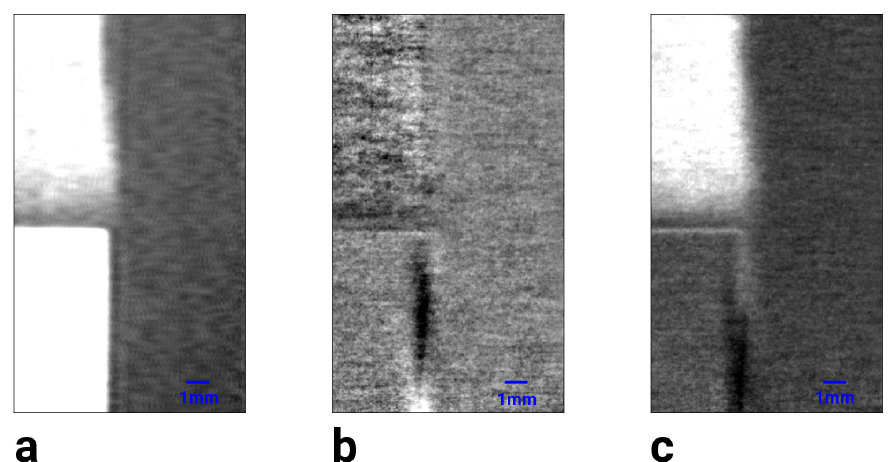
Figure 7. Attenuation ( a ), differential phase-contrast ( b ) and dark-field ( c ) image of the phantom reconstructed by using the Gaussian shaped filters and the sliding window reconstruction. The sponge ( top ) and the PMMA step-wedge ( bottom ) are shown. No artifacts are observed in the images. The images correspond to the green area in Figure 2.